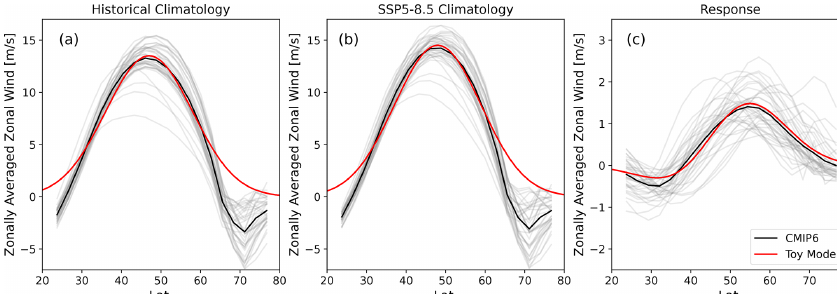
Figure B1. As in Fig. 5 but for the Indo-Atlantic sector (300–120 ◦ ).